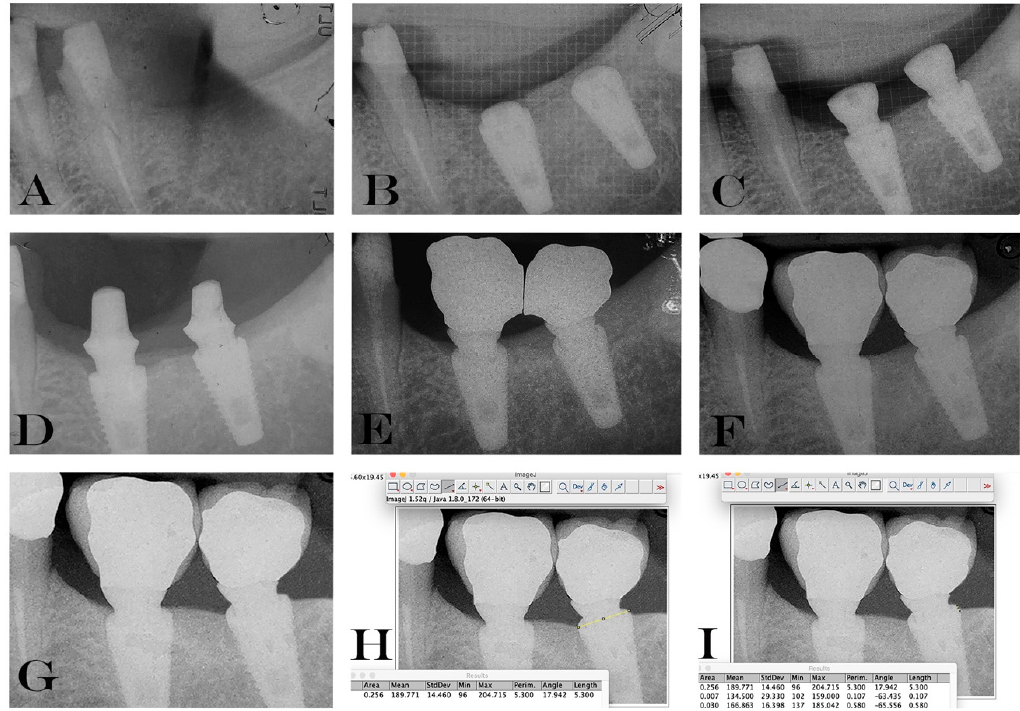
Figure 3. Periapical radiographs showing all the phases of the study ( A – G ): ( A ) pre-operative periapical radiography; ( B ) immediately after implant placement; ( C ) at the second surgical stage; ( D ) cementation of final abutments; ( E ) crown structure test; ( F ) delivery of the permanents metal-ceramic crowns; ( G ) radiograph taken 4 years after implant insertion. ( H – I ) demonstration of the MBL measurements with computer-assisted calibration to guarantee a correct measurement also in cases where the radiograph was slightly